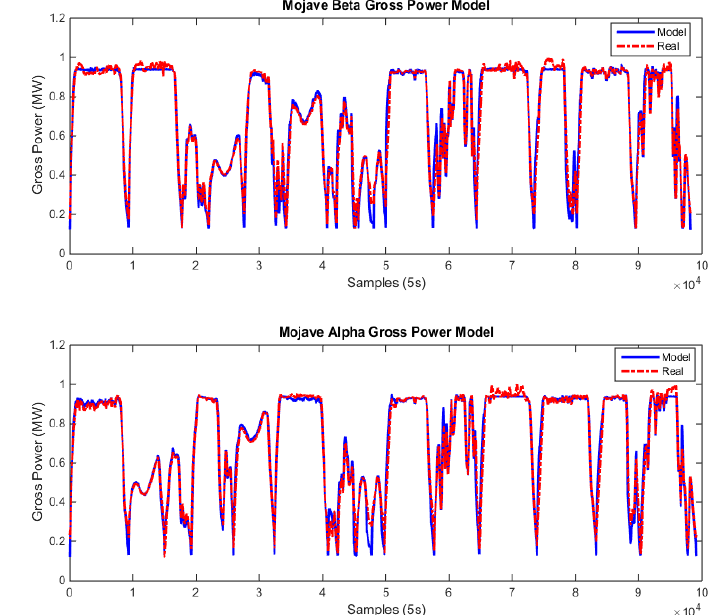
Figure 16. Mojave Beta and Alpha: Gross Power Model: ( top ) Mojave Beta model, showing real evolution (red dash-dotted) and model output (blue solid); and ( bottom ) Mojave Alpha model, showing real evolution (red dash-dotted) and model output (blue